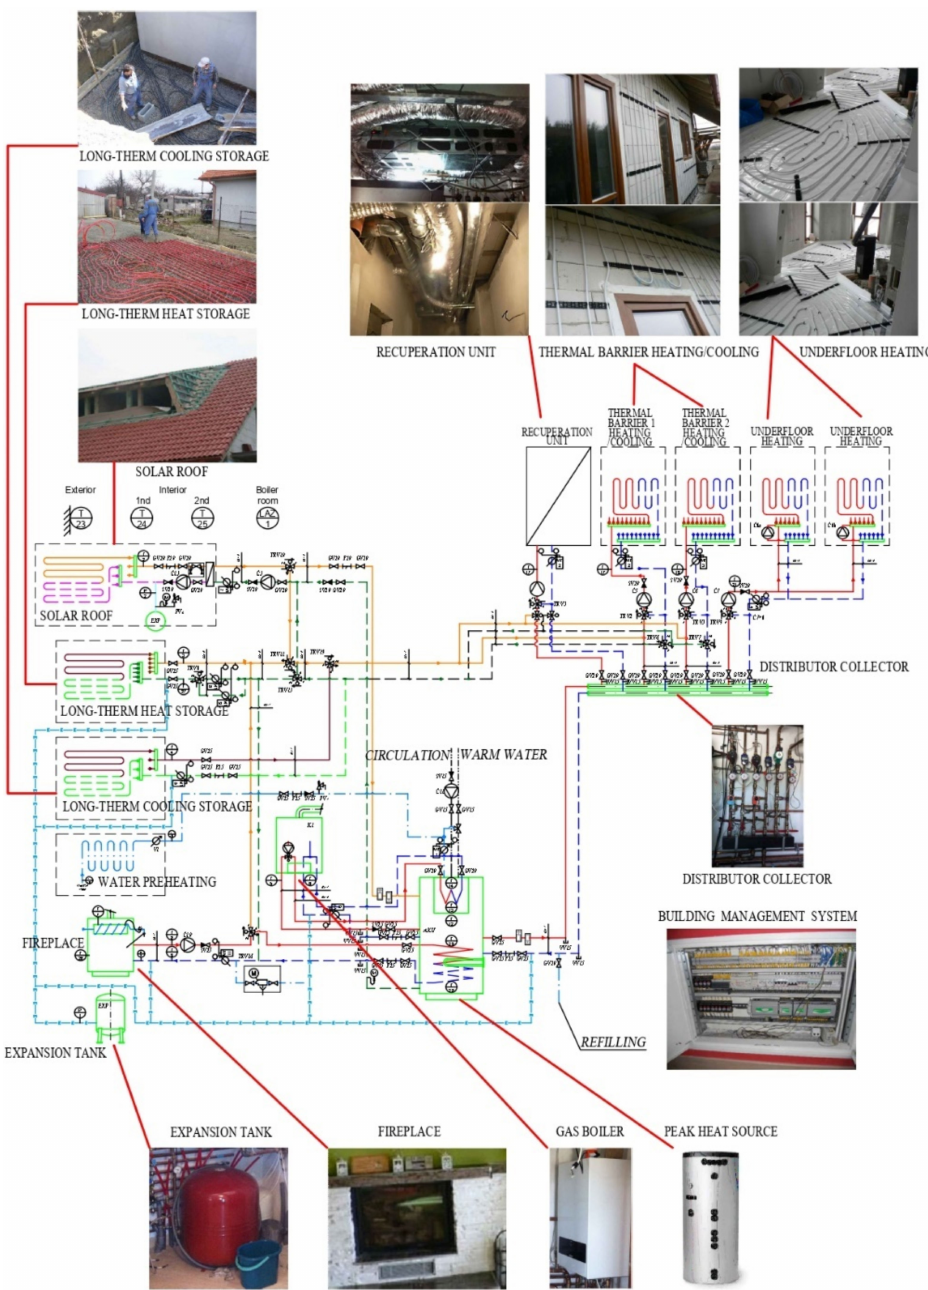
Figure 28. Wiring diagram of the technical solution of the energy systems of the experimental house EB2020. [Author: Kal ú